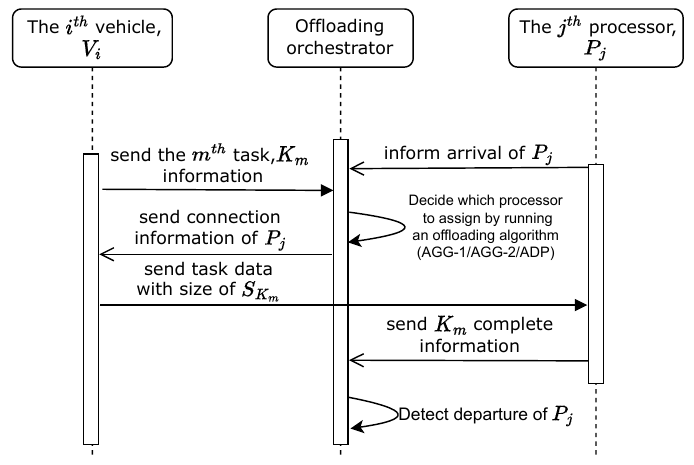
Figure 2. Task offloading sequence